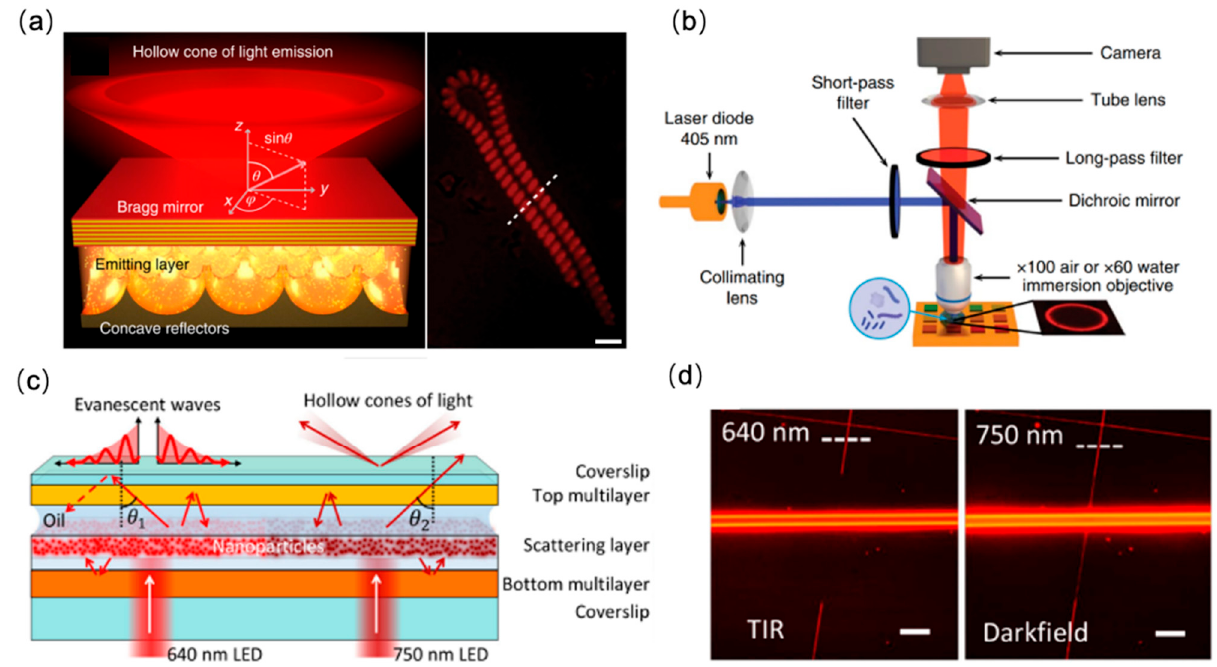
Figure 2. Metasurface-enabled darkfield microscopy. ( a ) Left: Schematic of the luminescent photonic substrate. Right: Darkfield image of a micro-algae on the nanophotonic substrate. Scale bar: 5 μ m. ( b ) Schematic drawing of the microscope used for imaging with the luminescent surface as the imaging substrate. Reprinted with permission from Ref. [57]. Copyright 2020 Springer Nature. ( c ) Design of the planar photonic chip for darkfield illumination (at 750 nm excitation) and total internal reflection imaging (at 640 nm excitation). ( d ) Imaging demonstration of two polymer nanowires. Scar bar: 20 μ m. Reprinted from Ref. [58].